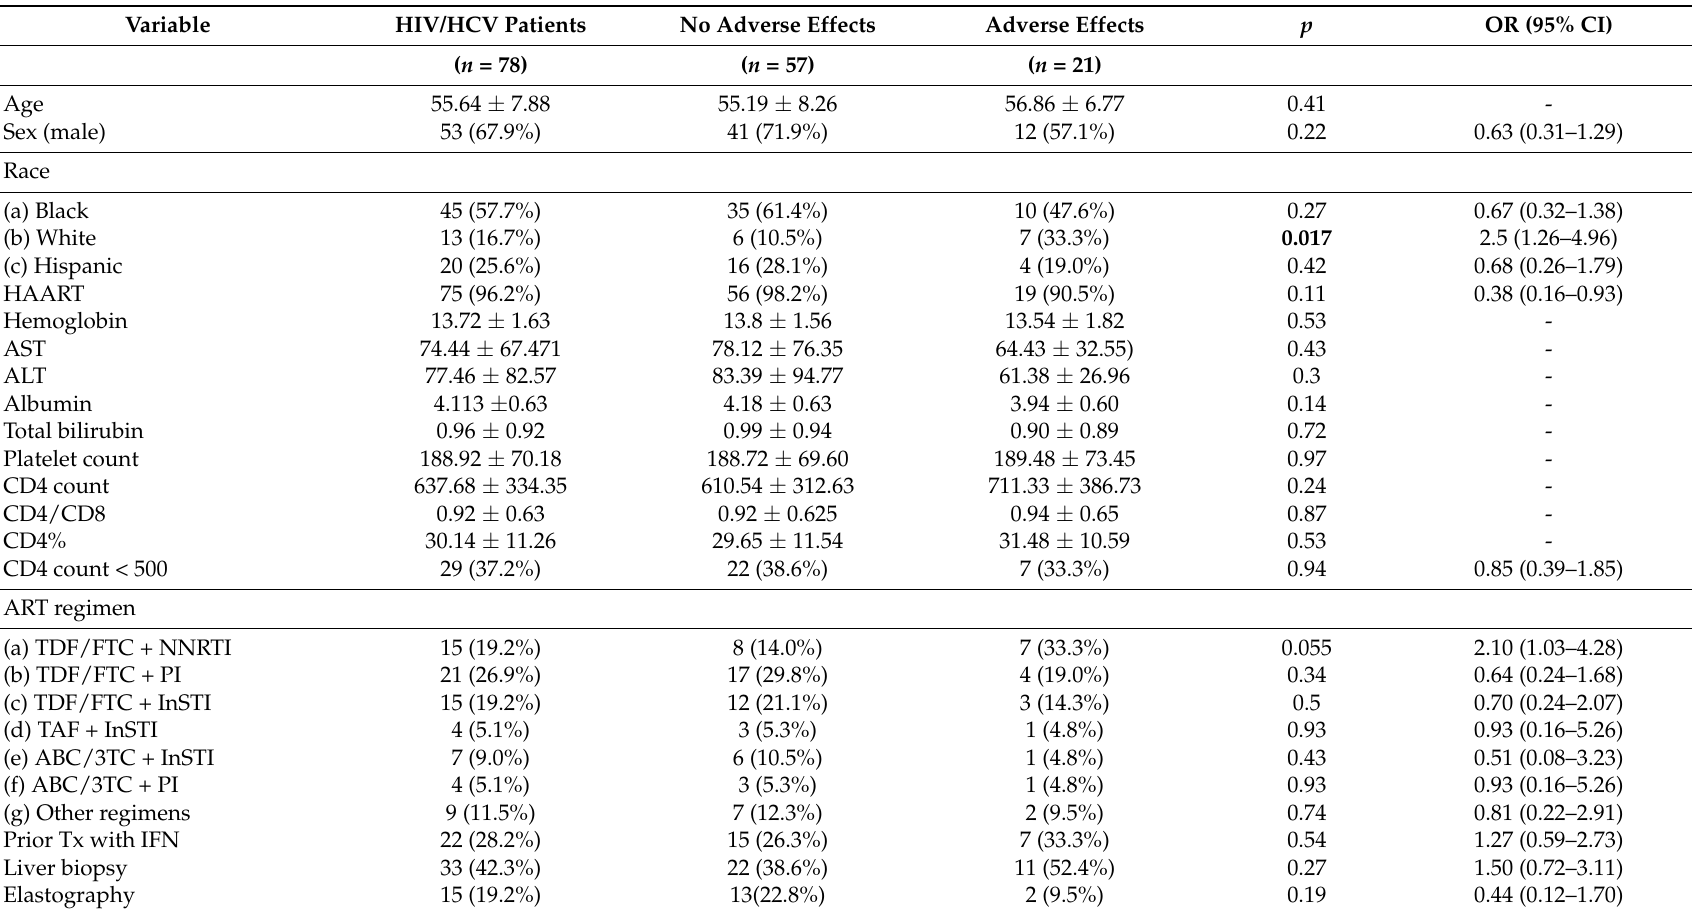
Table 1. Clinical, laboratory, and treatment characteristics of HIV/HCV coinfected patients and a comparison by the development of DAA adverse